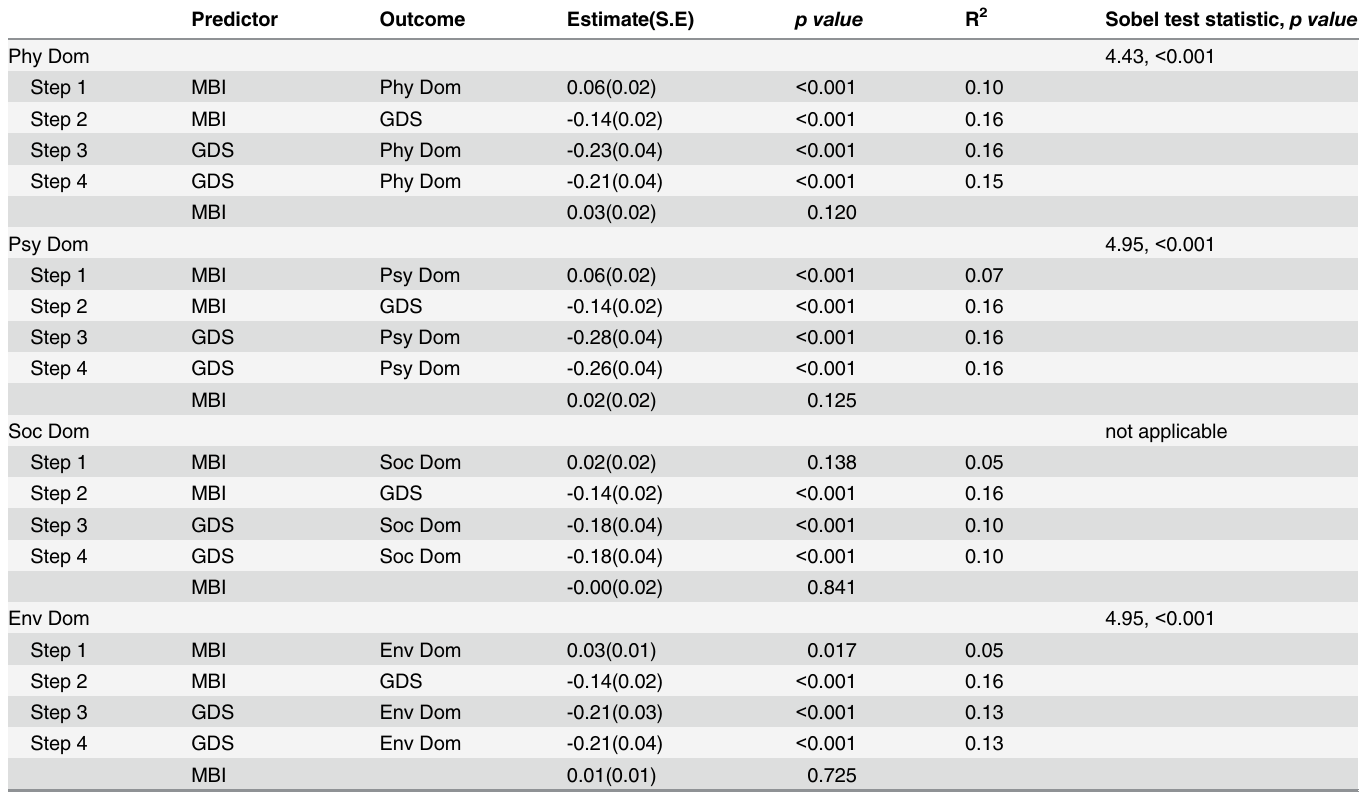
Table 3. Regression analyses testing the mediation of GDS in the relationship between MBI and four domains of WHOQOL-BREF.